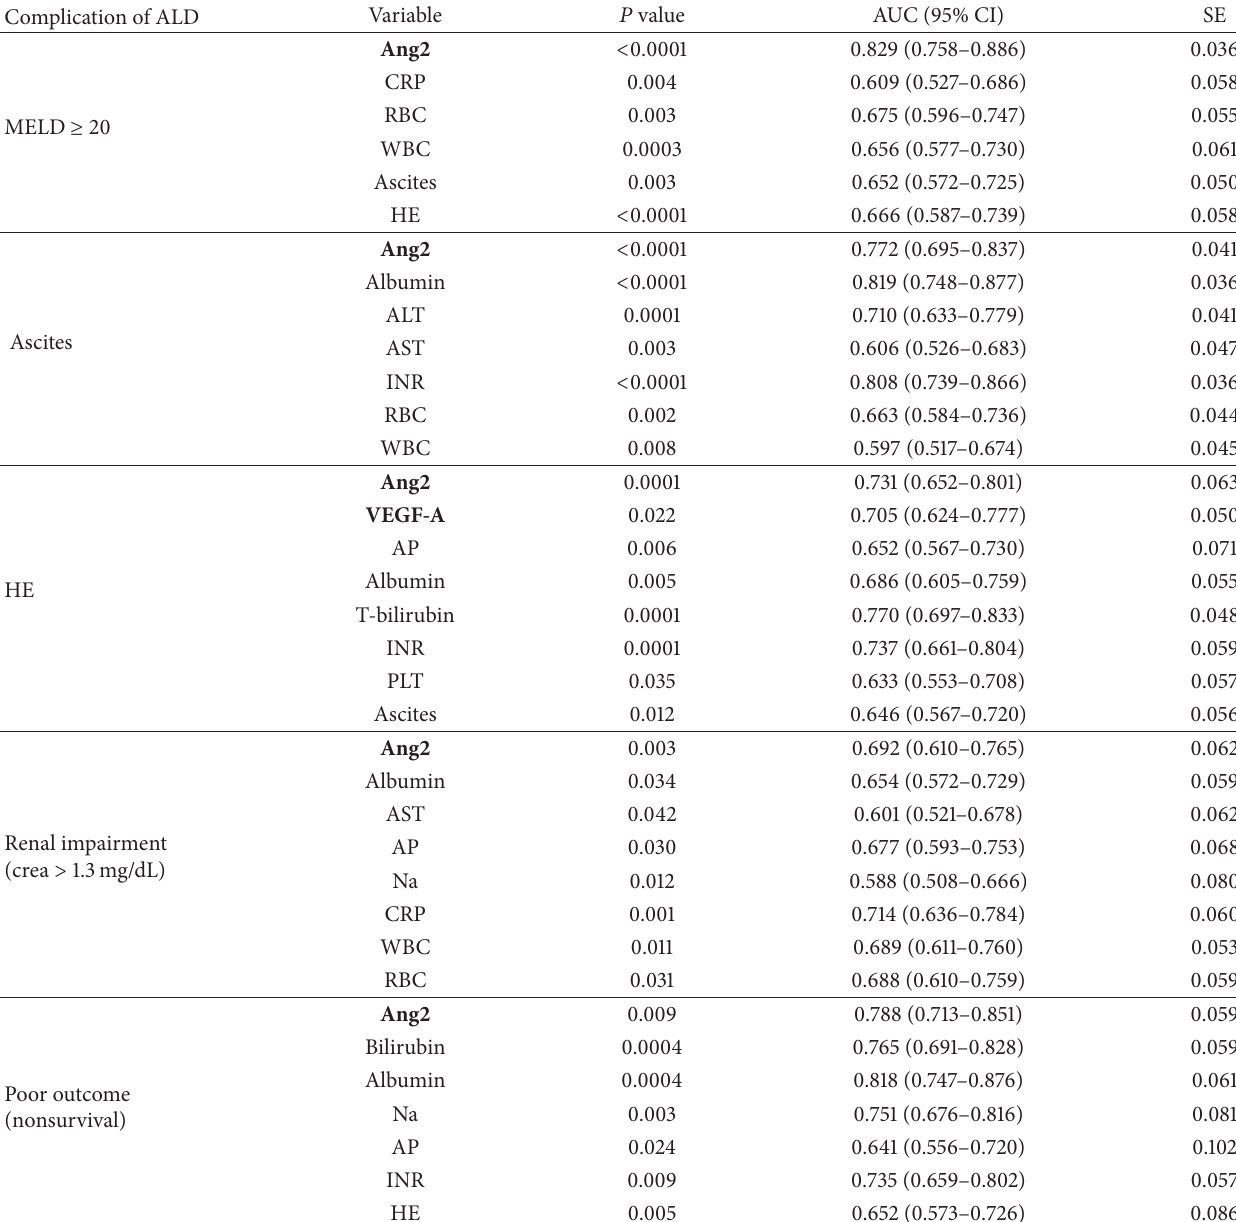
Table 6: Comparison of the diagnostic accuracy (AUC) of single variables in the diagnosis of advanced liver dysfunction (MELD ≥ 20) and ALD complications (univariable analysis) ∗